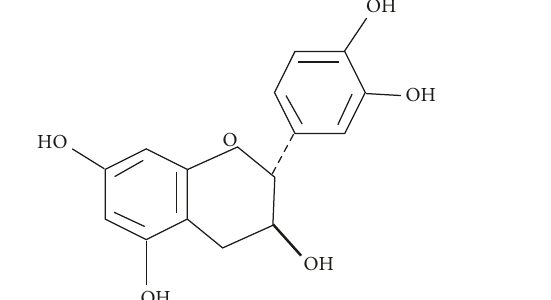
Figure 4: Chemical structure of